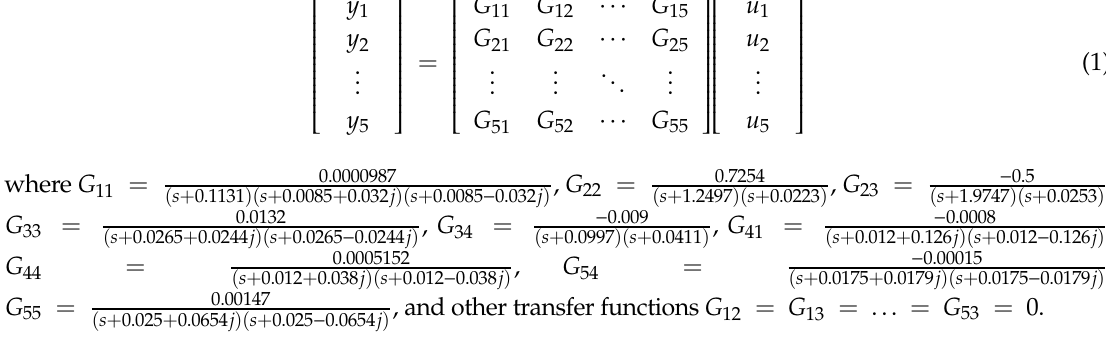
Table 1. The parameters used in the steam / water